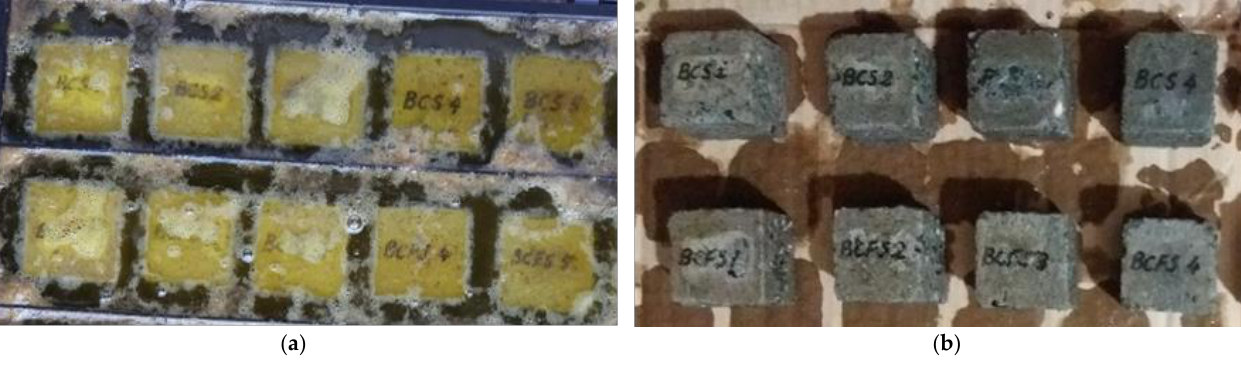
Figure 2. Resistance to the action of hydrochloric acid: ( a ) Specimens immersed in 18% HCl solution; ( b ) Specimens’ aspect after 10 days of immersion in 18% HCl solution. Table 2. Mechanical and durability test